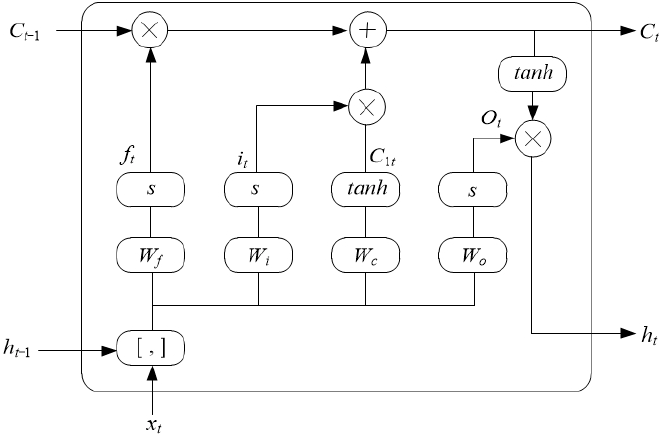
Figure 1. Structure of LSTM.